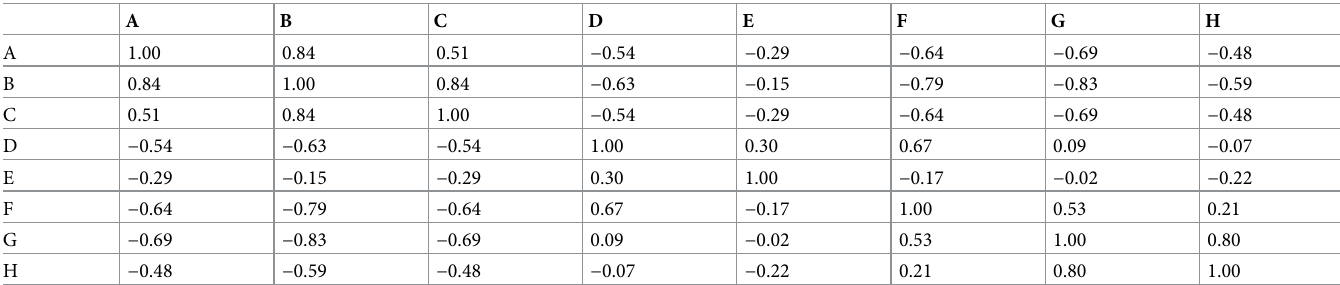
Table 2. The correlation matrix between nodes in a hypothetical network in Fig 1 provided by our walk betweenness